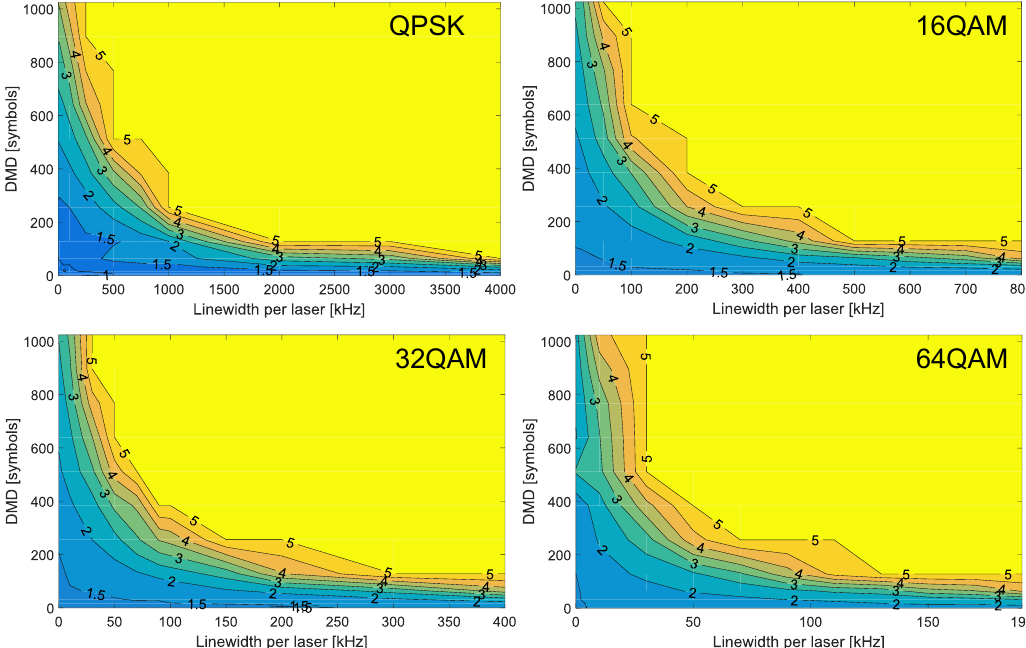
Figure 8. OSNR penalties in dB, computed at a BER of 10 − 4 , for model B and QPSK, 16-QAM, 32-QAM and 64-QAM modulation